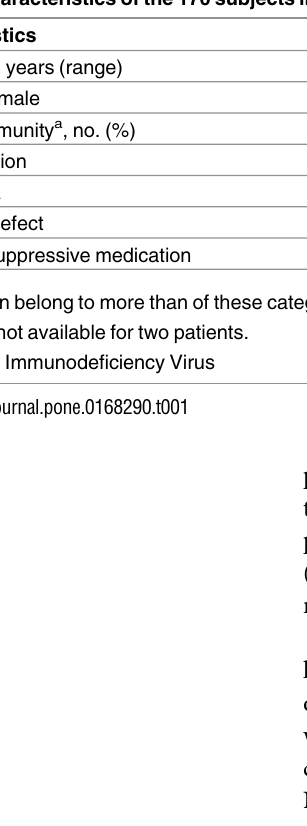
Table 1. Characteristics of the 170 subjects included in the study.